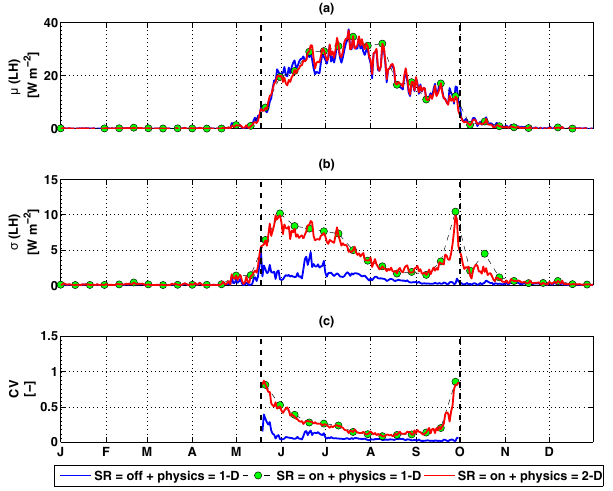
Figure 10. Latent heat flux interannual (a) mean, (b) standard devi- ation, and (c) coefficient of variation across the site A transect.